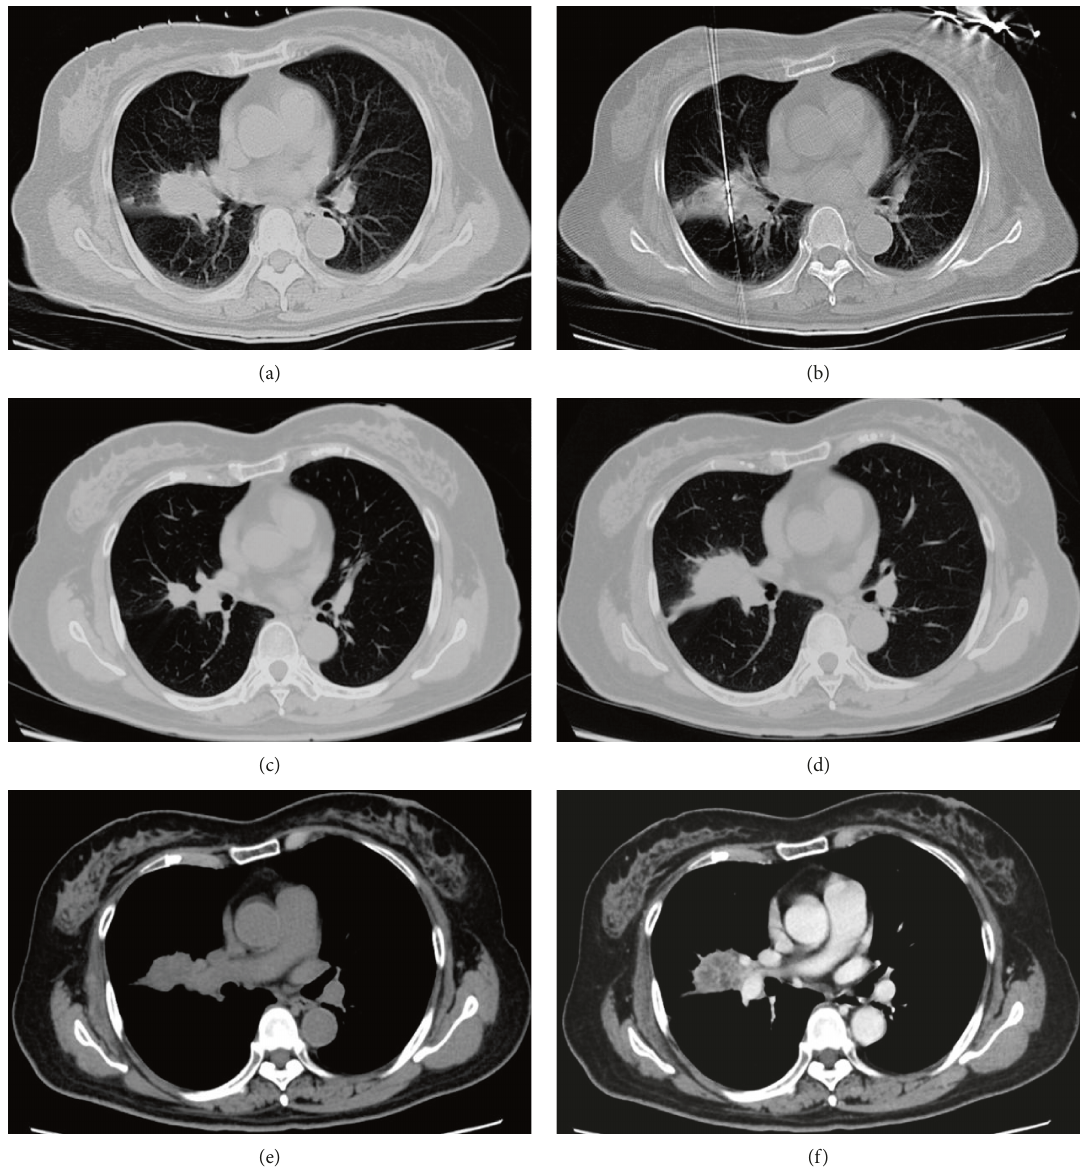
Figure 3: A 66-year-old female with nodular lung metastatic lesion with a diameter of 2.5cm (a). Ablation was performed after accurate insertion of MWA probe into the focus of tumor (b). The lesion reduced obviously with some fi ber cable around it on 3 months follow-up (c). However, the volume of the tumor increased again on 6 months follow-up ((d) lung window; (e) soft tissue window; (f) contrast- enhanced CT), which was consistent with the description of local tumor